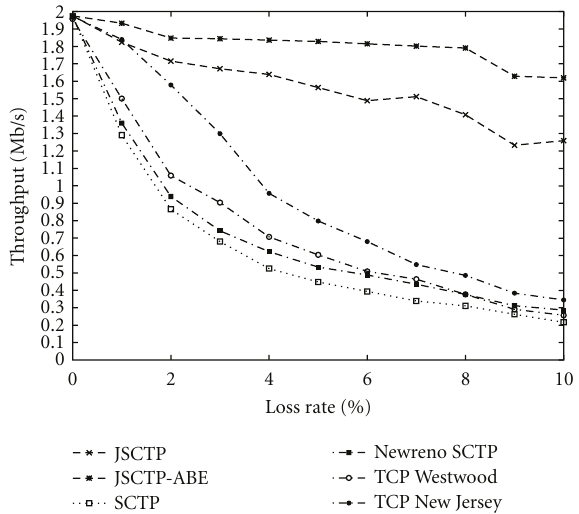
Figure 8: Throughput comparison with 1 ∼ 10% loss on primary path.